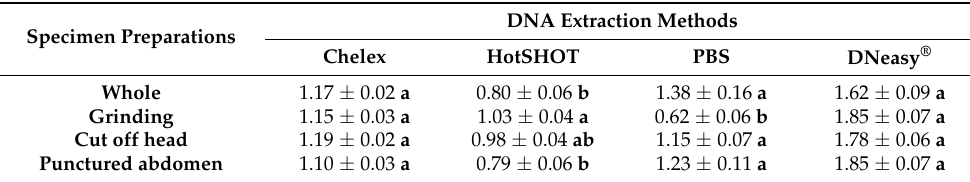
Table 4. Comparison among DNA purity ratios A 260 /A 280 (mean ± SE, n = 14) of the specimen preparation procedures in four DNA extraction